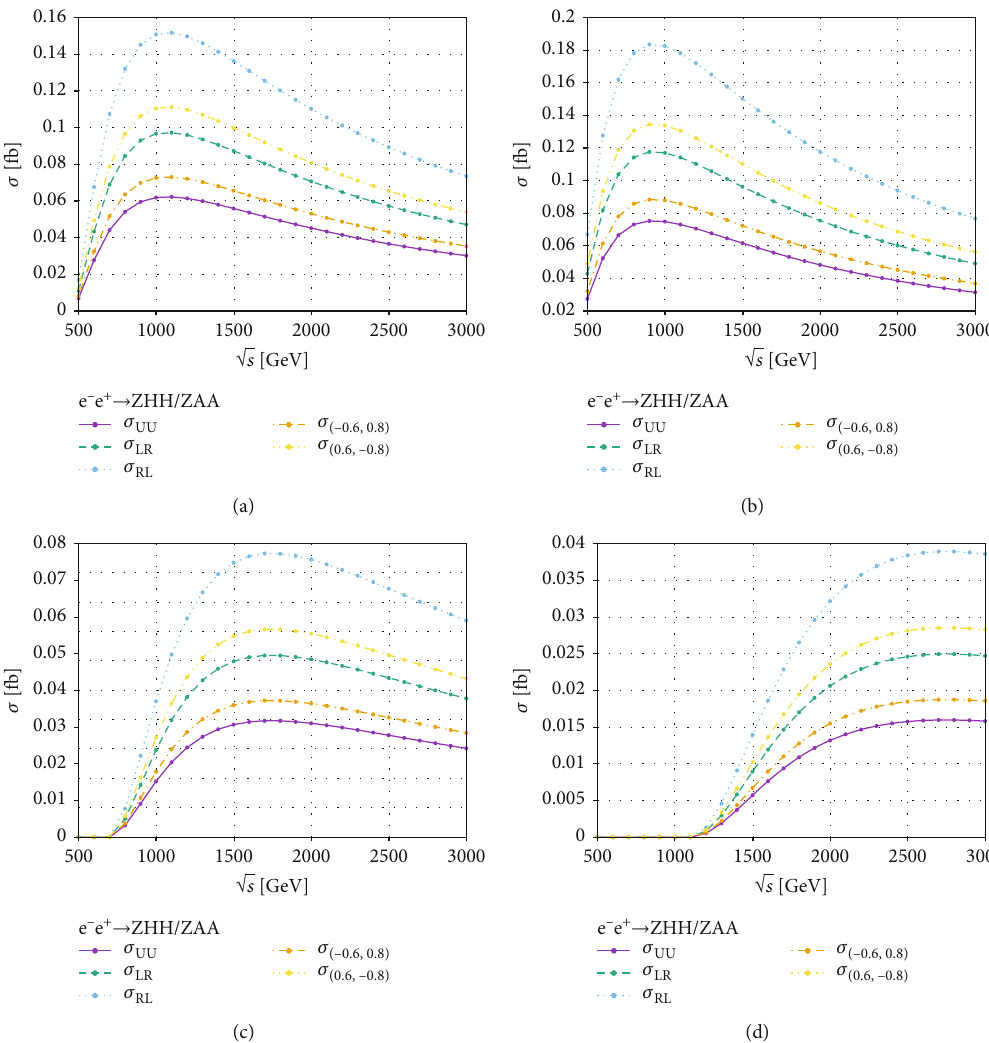
ffiffi p ( GeV ) is shown in these fi gures. Higgs mass values m ϕ = 150GeV , s